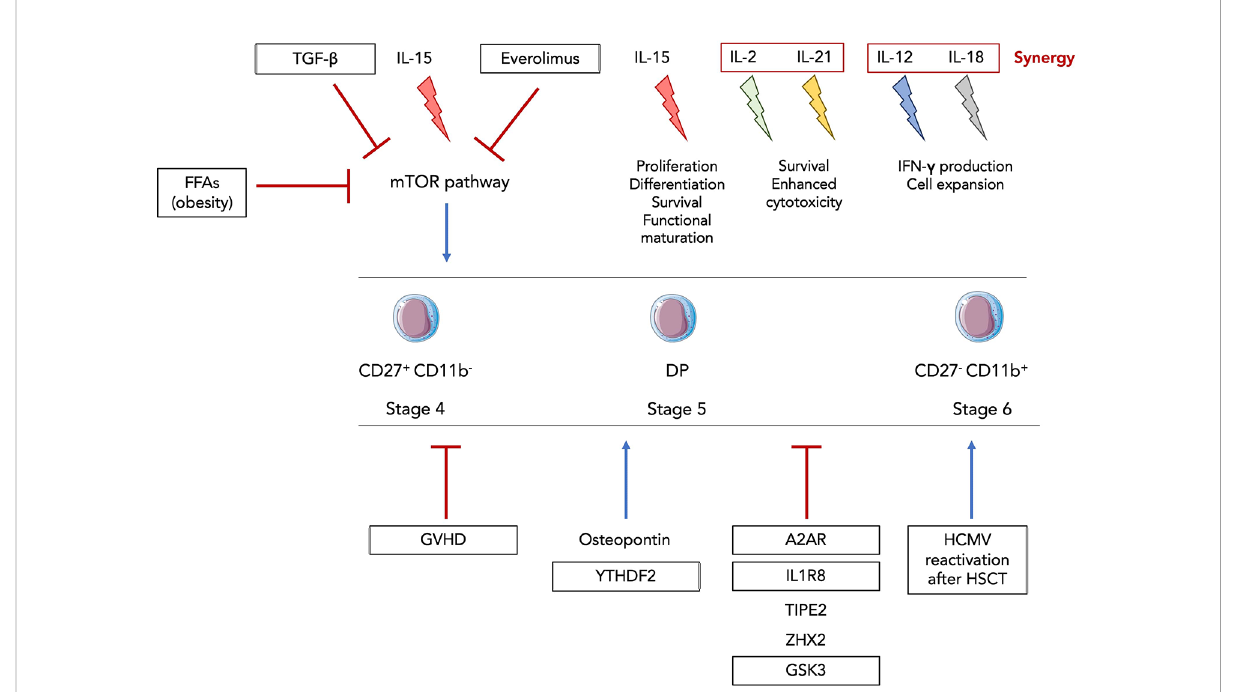
FIGURE 4 In fl ammatory-driven regulation of NK cell functional maturation. The family of common g c cytokines is known to be involved in NK cell development and functional activation. IL-15 is the main cytokine driving proliferation, differentiation, survival and functional maturation and can act on all stages of murine and human CD122 + NK progenitors and precursors. IL-2 and IL-21 can synergize and promote survival of mouse and human NK cells as well as enhance their cytotoxic activity. IL-12 and IL-18 also synergize to activate NK cells and amplify their expansion and production of IFN g (140). Everolimus, free fatty acids (FFAs) in obsesity and TGF- b were shown to inhibit the IL-15-mediated activation of the mTOR pathway. GVHD, A2AR, IL1R8, TIPE2, ZHX2 and GSK3 were discovered as newly factors and pathological context negatively regulating NK cell functional maturation while osteopontin, YTHDF2 and HCMV reactivation after HSCT promote it. Framed factors and in fl ammatory contexts were validated in human NK